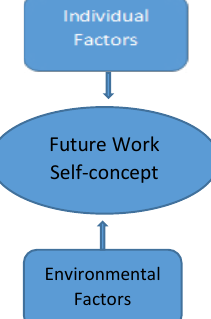
Fig. 2: Conceptual model of factors affecting the formation of career path with a postmodern approach